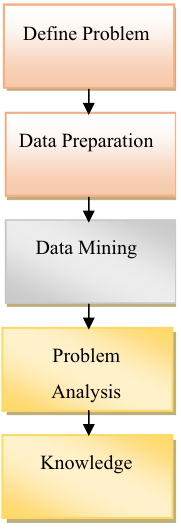
Figure 3: Data - mining fl